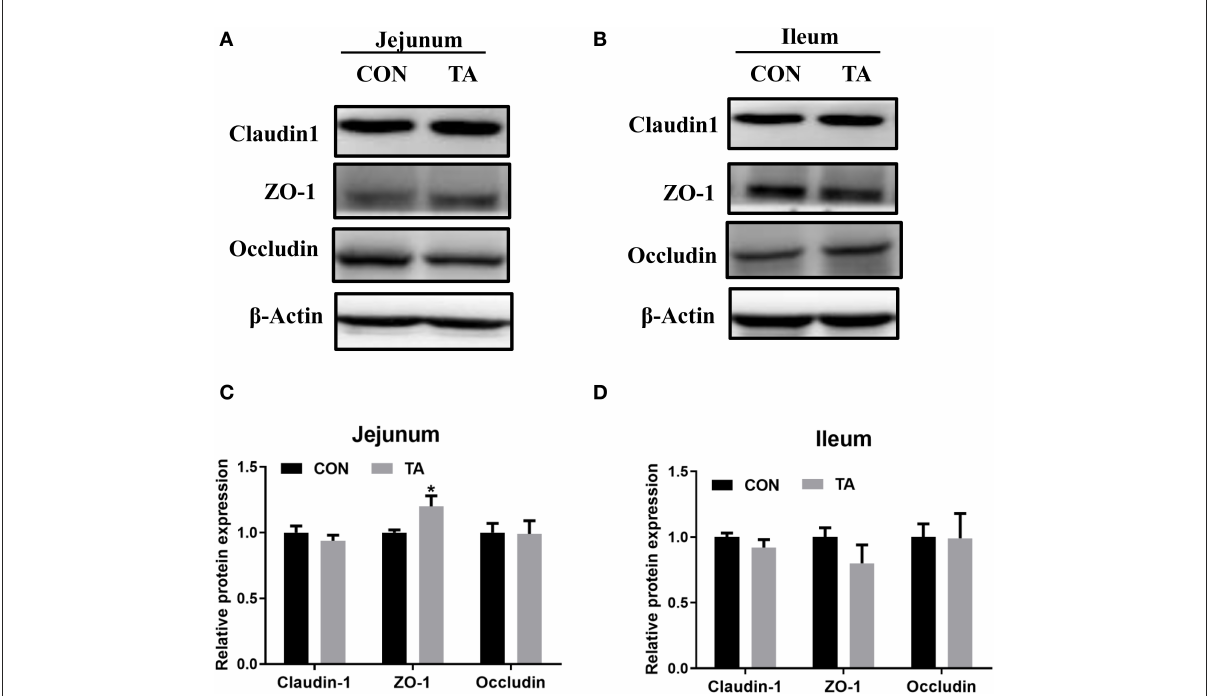
FIGURE2 Effects of tannic acid (TA) on the intestinal tight junction in weaning piglets. The relative protein levels of intestinal tight junction proteins in the jejunum (A) and in the ileum (B) . Quantitative analysis of the relative protein levels of intestinal tight junction proteins in the jejunum (C) and in the ileum (D) . CON, basic diet; TA, a basic diet supplemented with 1,000 mg/kg tannic acid. Data are presented as mean ± SEM, n = 9. * P < 0.05. * means comparing to the CON